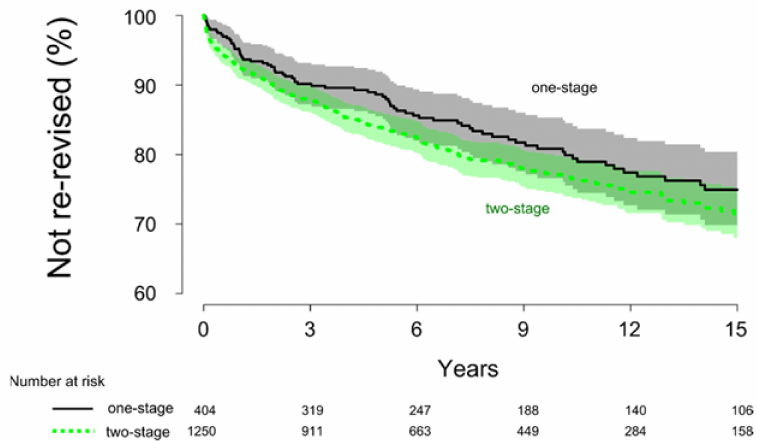
Figure 2. Kaplan-Meier survival analysis comparing the one- and two-stage procedure using re-revision due to all causes as an endpoint. The cumulative survival rate at 15 years after surgery was found to be similar between the two procedures ( p =